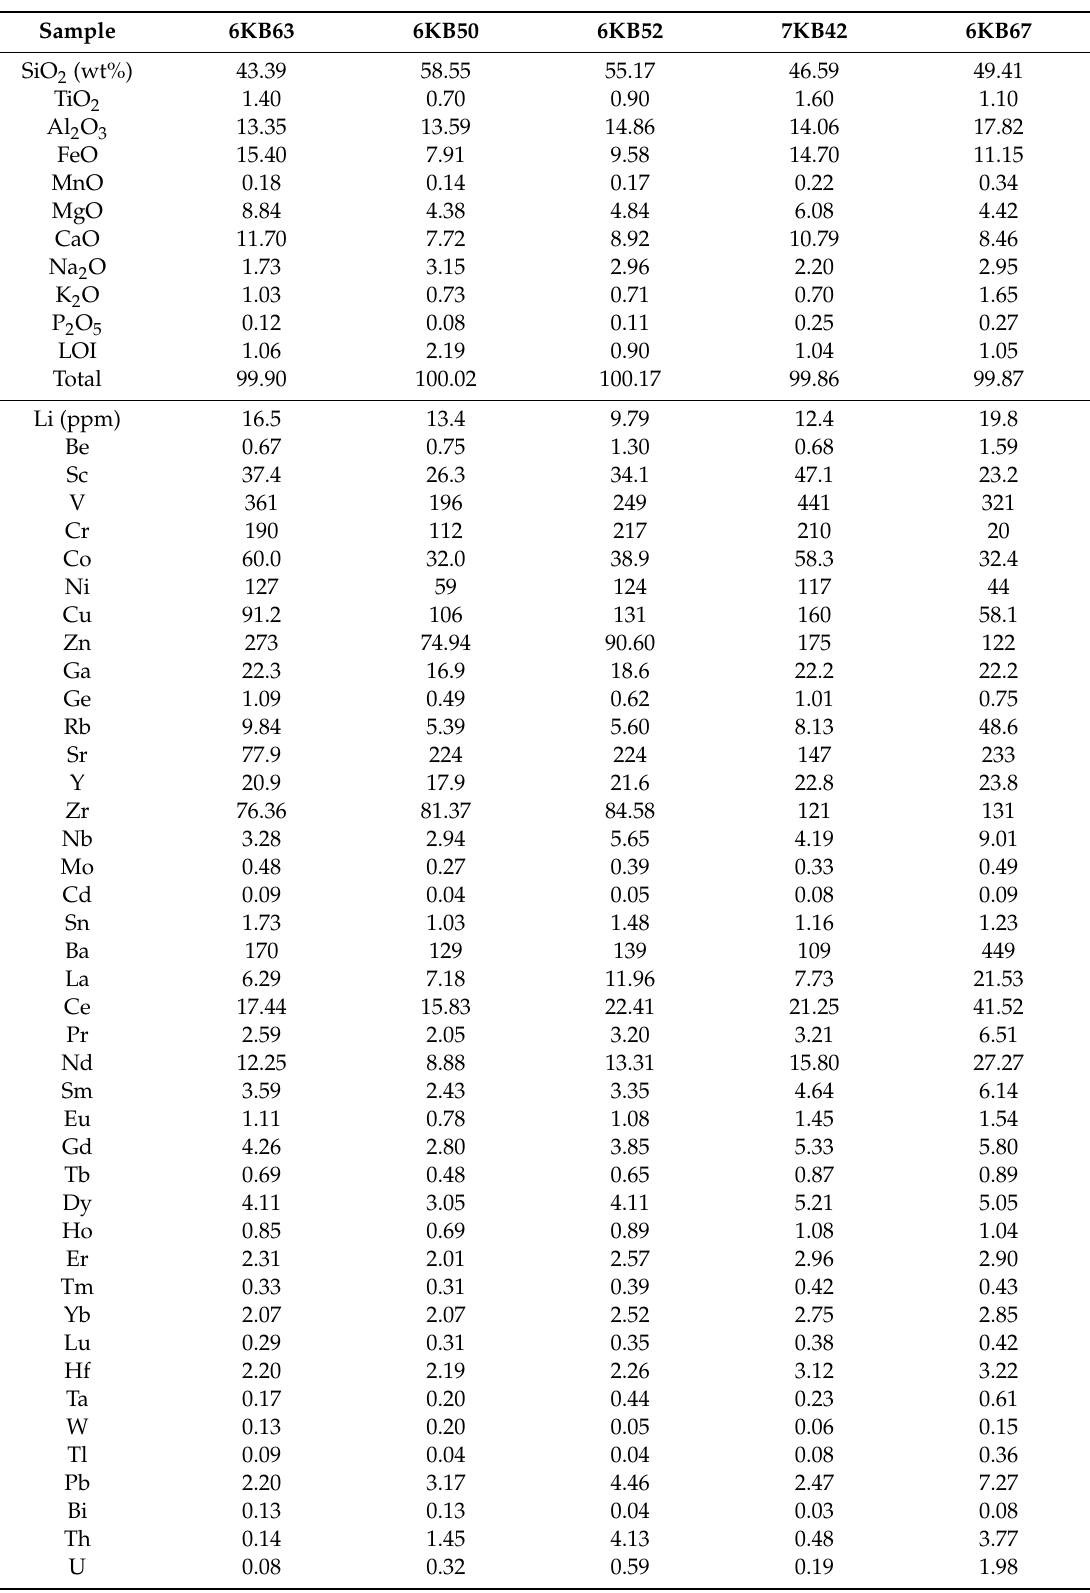
Table 2. Bulk rock major (wt%) and trace element (ppm) concentrations of the KSZ samples obtained by XRF and solution ICPMS,